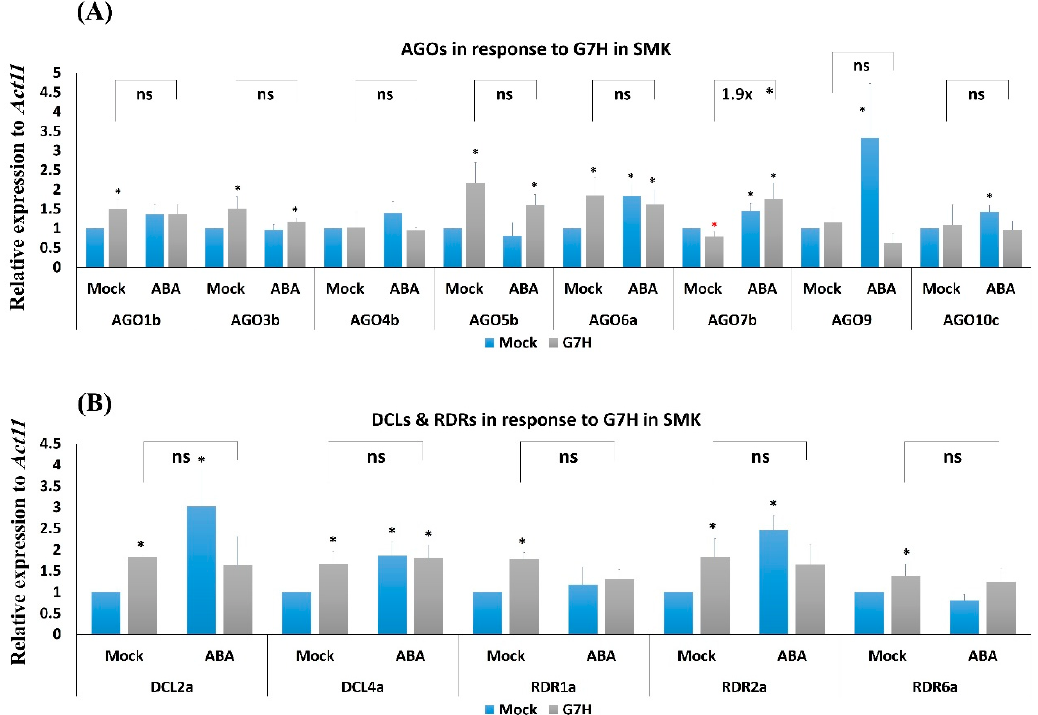
Figure 5. Expression levels of RNA-silencing genes in SMK plants infected with G7H. Expression levels of AGO genes ( A ), and DCL and RDR genes ( B ) in SMK soybean cultivar ( rsv3 -null) in response to G7H infection, ABA treatment, or both. Plants were collected 5 dpi for RNA extraction and RT-qPCR. Values are means ± SD of three biological replicates. Statistical analysis was carried out for each gene using Student t -test; the means for plants treated with ABA alone, G7H alone, or the combination of ABA and G7H were individually compared with the mean for plants that were not treated with ABA or G7H: * and * indicate a significant increase or decrease, respectively, at P < 0.05. Additional analyses were carried for ABA-G5H in comparison with Mock-G7H where ns and * indicate non-significance and significance at P < 0.05, respectively.